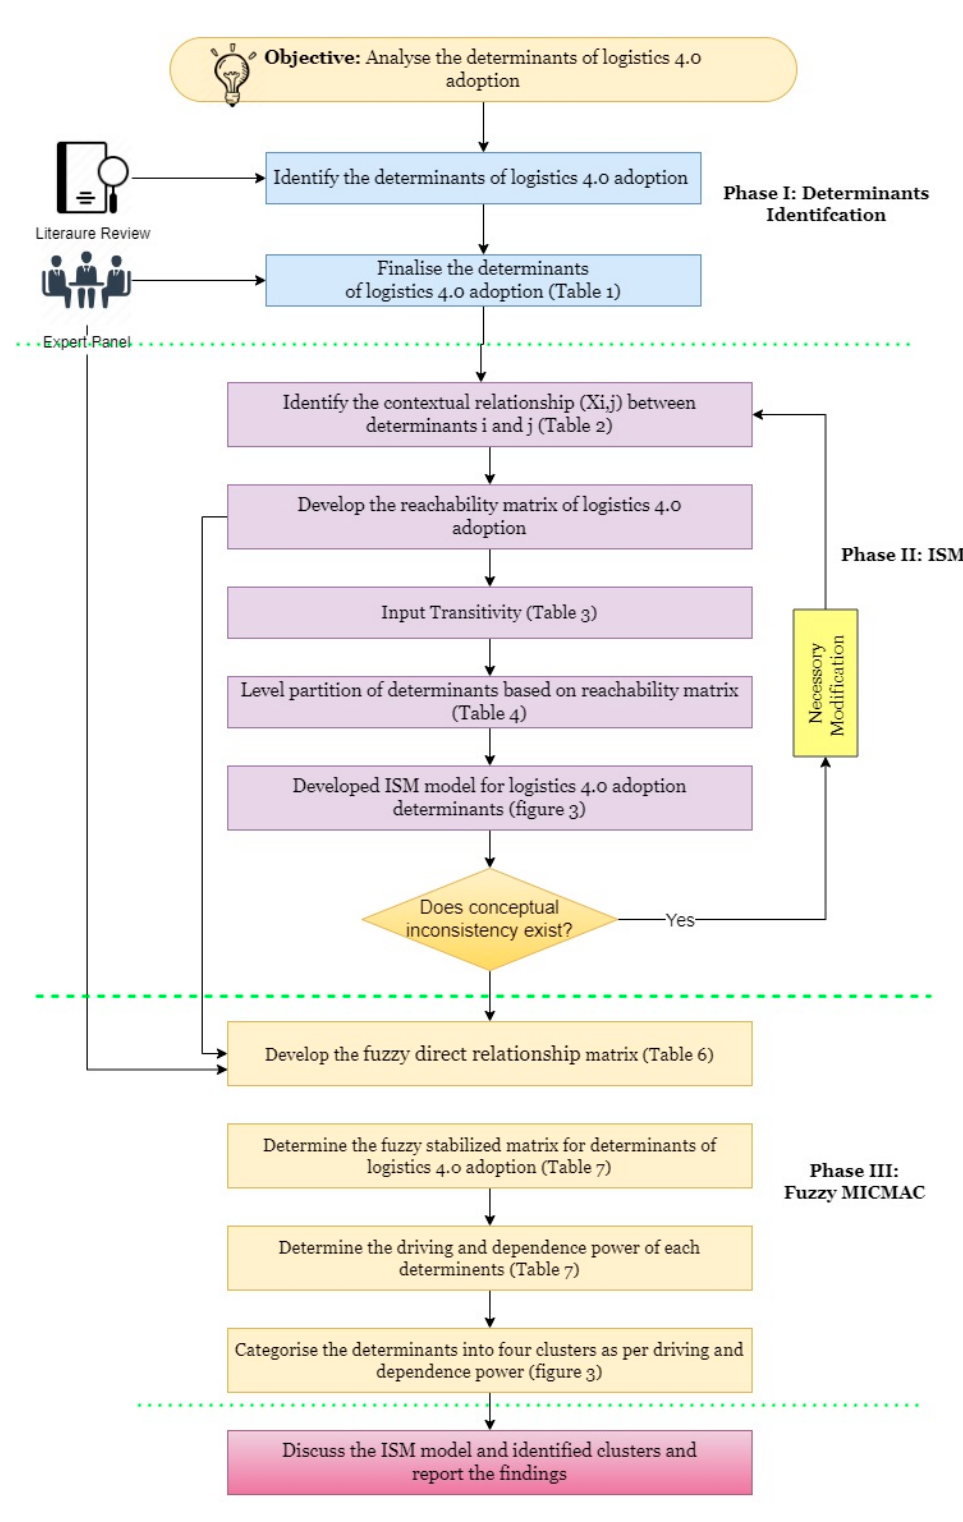
Figure 2. Proposed framework for modelling of determinants of logistics 4.0 adoption (Source: